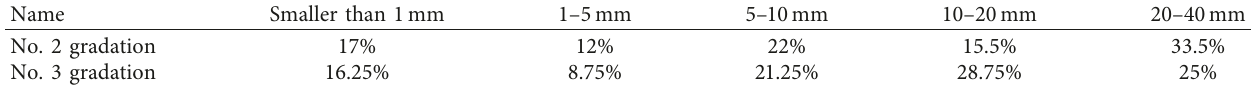
Table 1: Aggregate gradation for Material II.